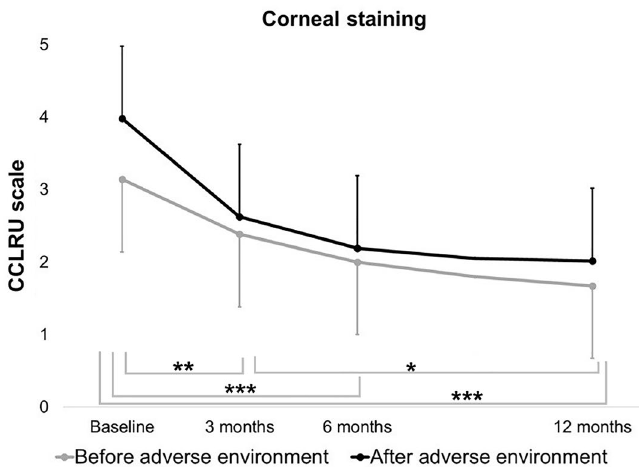
Figure 2. Fluorescein corneal staining. Scores based on the Cornea and Contact Lens Research Unit (CCLRU) scale were determined at baseline and at the 3-, 6-, and 12-month follow-up visits, before and after the exposure to the adverse controlled environment. Mean values and confidence interval error bars are represented. Grey bars represent comparisons between visits during exposure to the normal environment. * p = 0.0314, ** p = 0.0001, *** p < 0.0001. The adverse environmental exposure had a significant ( p = 0.0165) negative effect on corneal staining regardless of the visit. The interaction between the effect of the time and the conditions was not significant ( p =